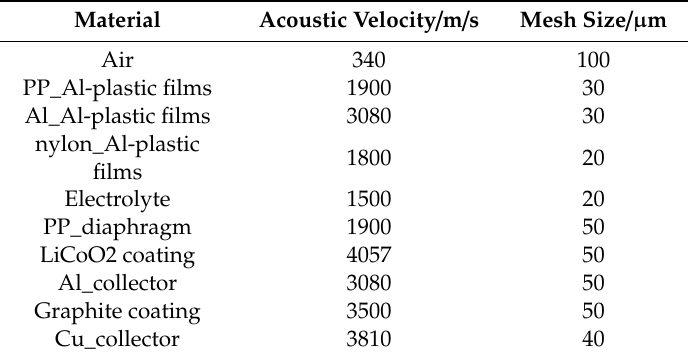
Table 1. Medium mesh size information.